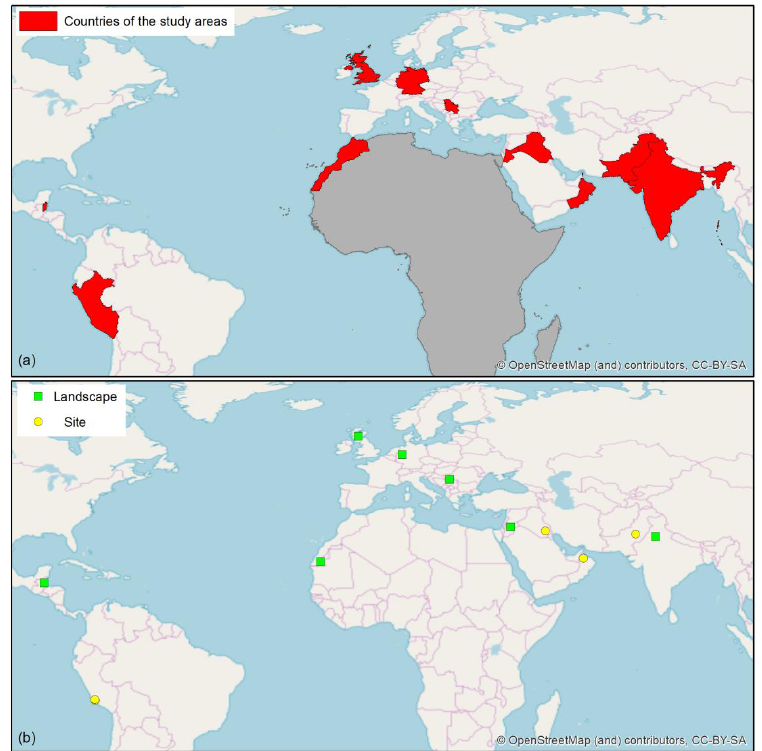
Figure 1. ( a ) Countries where the study areas of the papers published in the Special Issue are located; ( b ) geographic distribution of the study areas distinguished by typology (“landscape” in case of regional archaeological mapping and wide-area archaeological prospection; “site” in case of site-focused studies and investigations in single location). The African continent is marked in grey because one of the published papers [22] provides an overview of space law and space sciences for archaeological and heritage research in contemporary Africa.